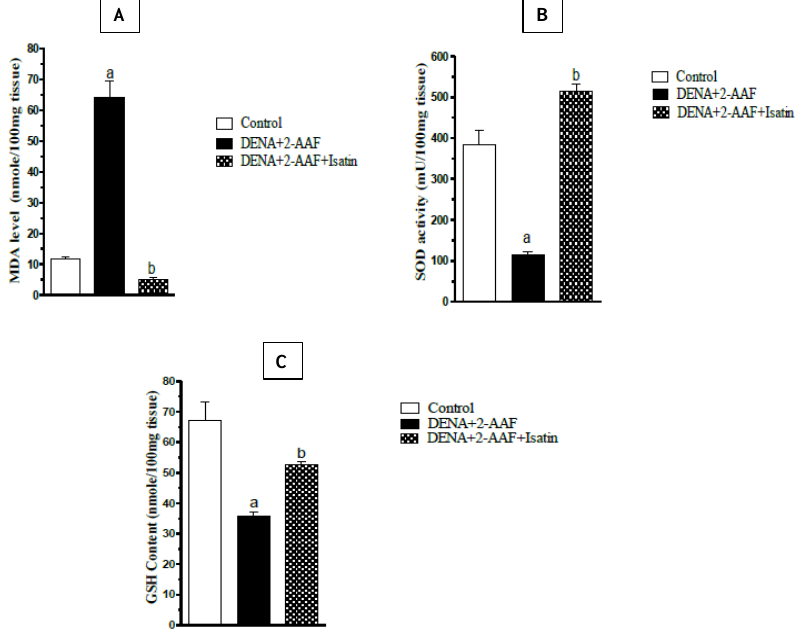
Figure 3. Isatin suppressed hepatic oxidative stress in HCC model rats. ( A ) Liver MDA concentration. ( B ) SOD activity. ( C ) GSH concentration. Data are presented as mean ± SEM. a p < 0.05 vs. control group. b p < 0.05 vs. DENA/2-AAF group.